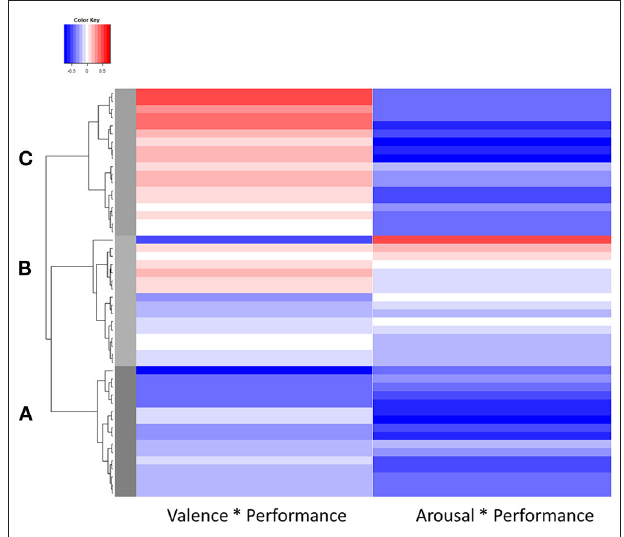
FIGURE 8 | Heat map of the cluster analysis.